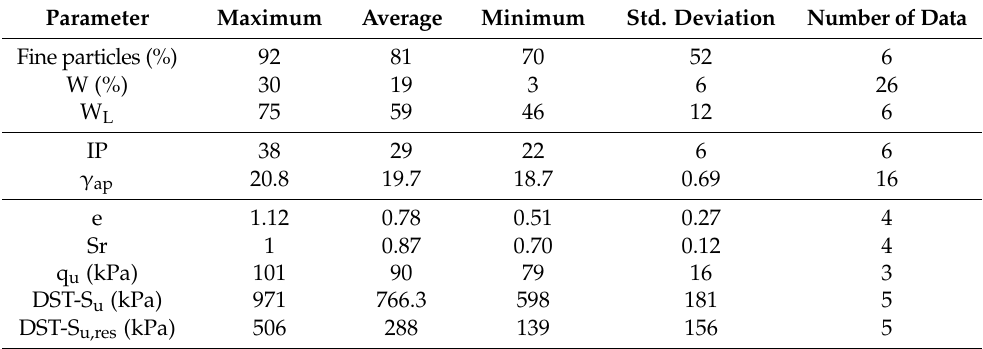
Table 4. Summary of the data from tests carried out with the cohesive levels. (W), moisture content; (W L ), liquid limit; (W P ), plastic limit; (e), void ratio; (Sr), degree of saturation; (q u ), unconfined compression strength; ( γ ) unit weight; (S u ), undrained shear strength; (DST), direct shear test. Parameter Std. Deviation